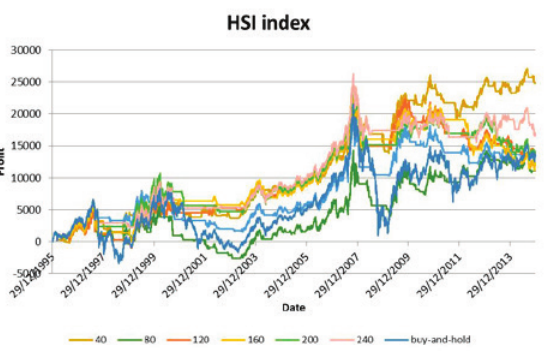
Figure 10. Profits of our strategy and “buy-and-hold” on UKX index (without transaction costs)